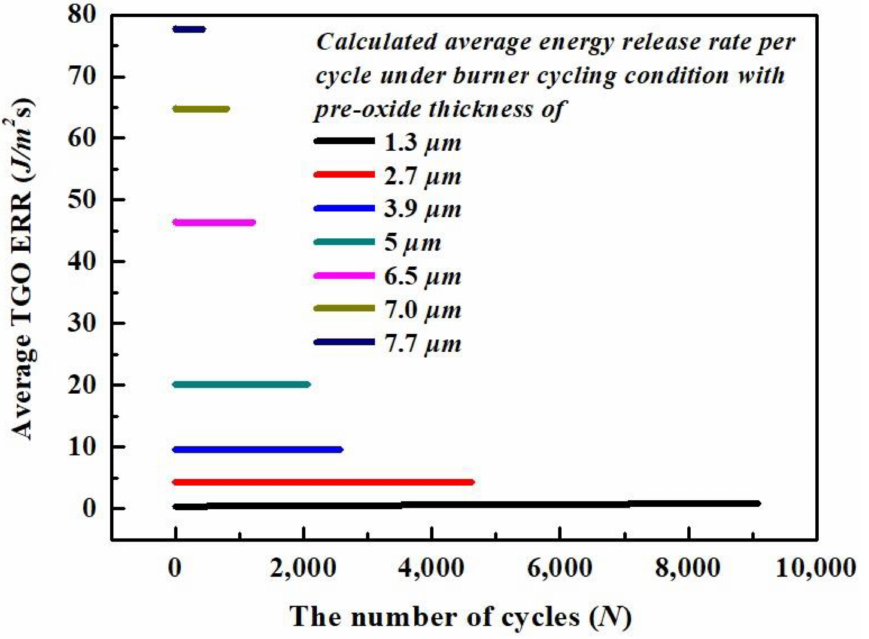
Figure 11. The calculated average TGO ERR vs. the number of cycles with respect to different pre-oxide thickness under burner cycling